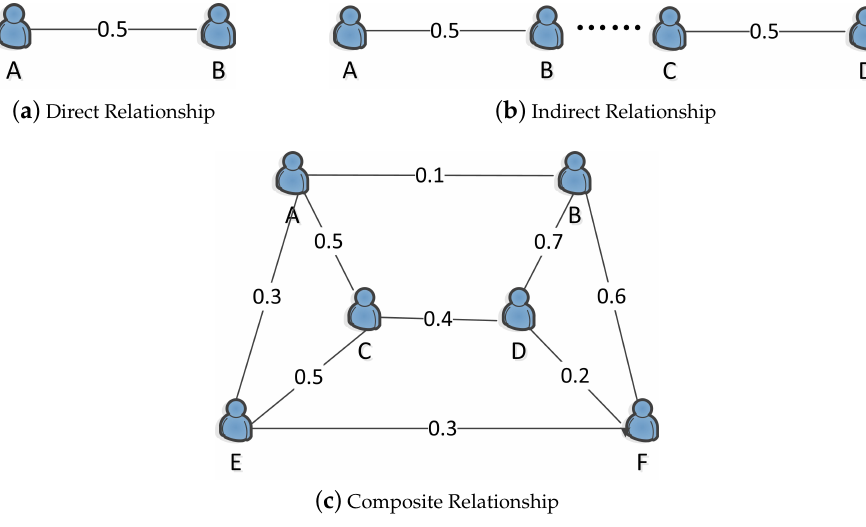
Figure 2. Types of